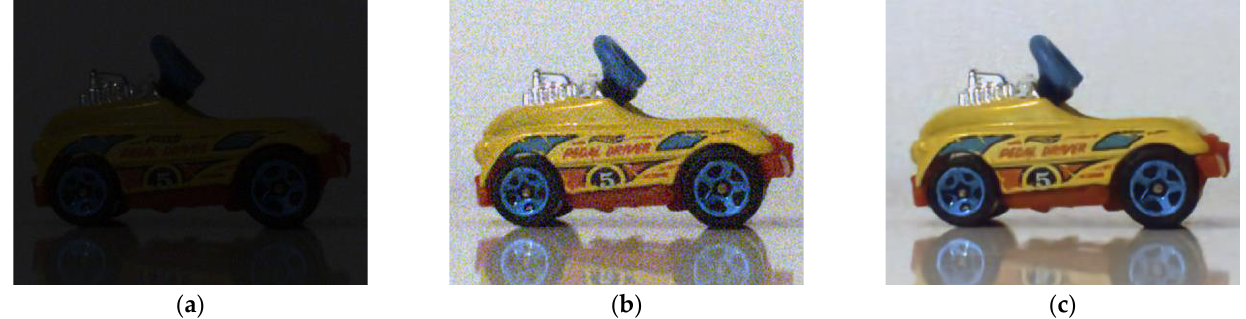
Figure 12. Short exposure acquisition (2 ms) on a moving object and application of LIP enhancement + denoising. ( a ) Motion acquisition with a short exposure time; ( b ) Noisy image after LIP enhancement; ( c ) Image after enhancement and denoising.